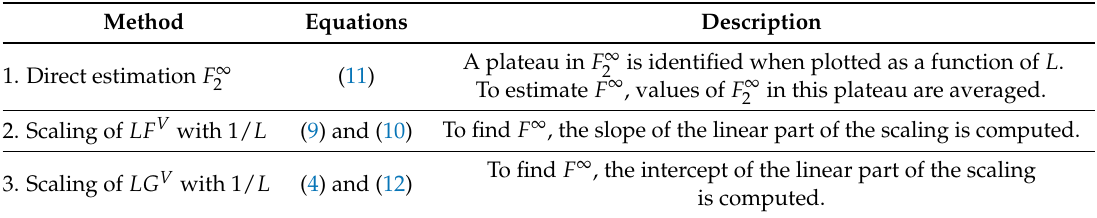
Table 2. A brief description of the methods used in this work to estimate the surface term in the thermodynamic limit F ∞ using RDFs computed from finite